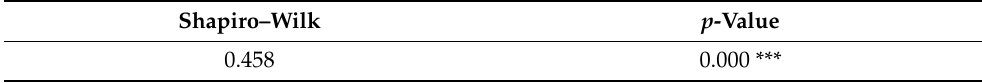
Table 8. Shapiro–Wilk Test for multivariate normality. Shapiro–Wilk